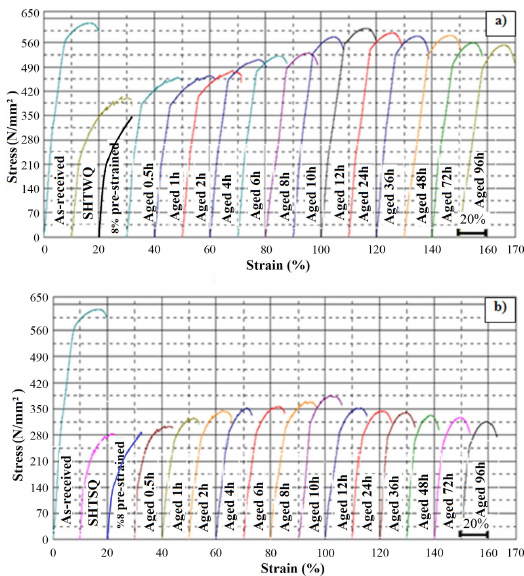
Figure 8. a) The microstructure and EDS analysis of T6 heat treated as-received b) SHTSQ c) SHTWQ 7075